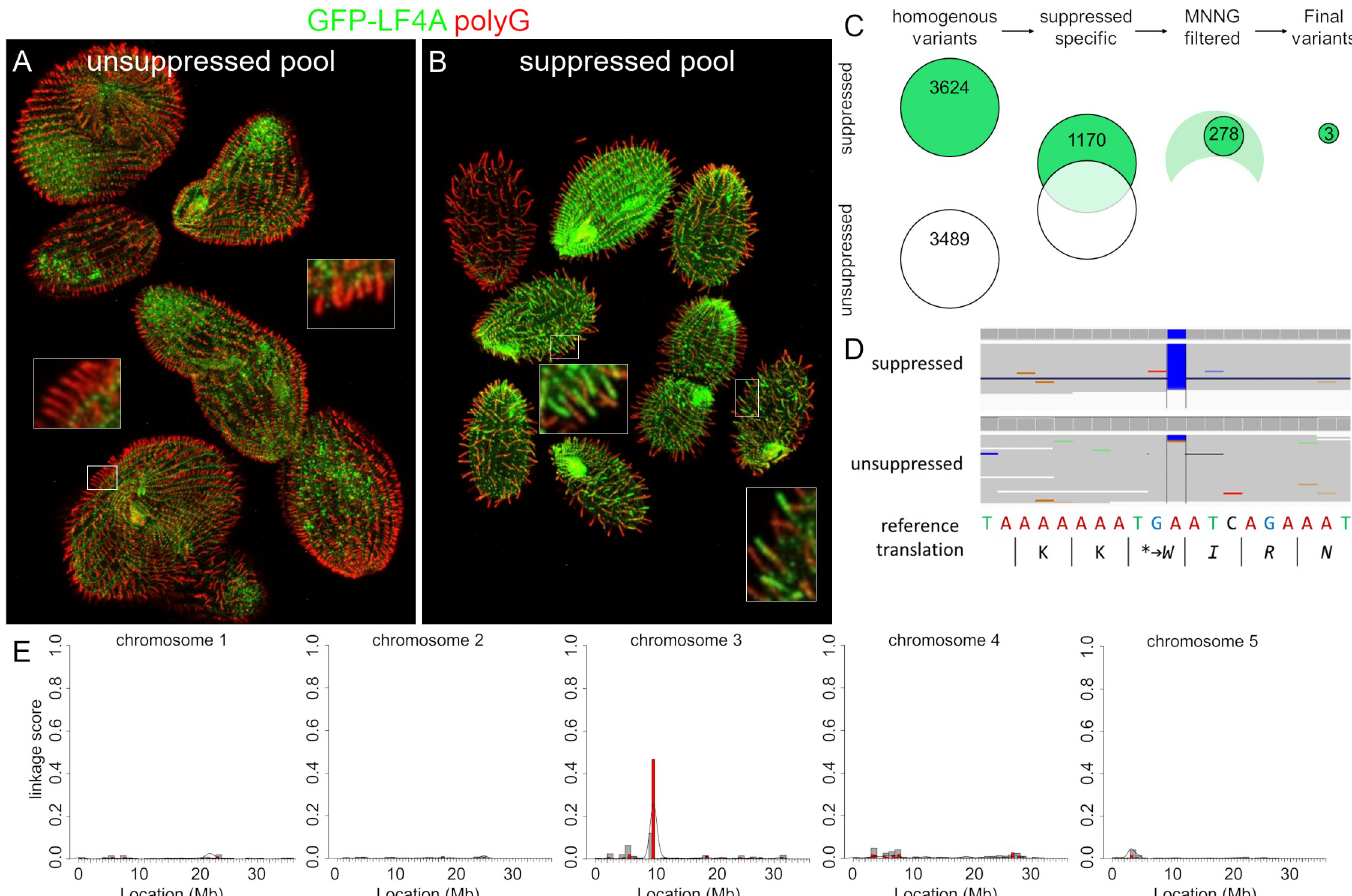
Fig 5. The extragenic suppressor clone SUP1 has a mutation in CDKR1 . (A-B) Immunofluorescence images of (unsuppressed and suppressed) pools of F2 progeny derived from a single sup1/SUP1 + (after an overnight exposure to Cd 2+ ) that were subsequently subjected to whole genome sequencing. Note the patterns of GFP-LF4A inside cilia: the base accumulation in the non-suppressed pool and the ciliary shaft and tip signals in the suppressed pool (see insets for higher magnifications). (C) The results of variant subtraction and filtering based on the alignment of sequencing reads to the macronuclear reference genome. Among the 278 variants consistent with nitrosoguanidine (MNNG) mutagenesis, three candidate variants affect a gene product and have a high fraction of reads supporting the alternative base in the mutant pool (see S1 Table). (D) An IGV browser view of the macronuclear genome sequence of TTHERM_01080590 ( CDKR1 ) that contains the variant scf_8254401:105680 T to C. This point mutation, supported by 100% of the sequencing reads from the mutant pool, changes the stop codon and adds a short peptide to the C-terminus of the predicted product. (E) An allelic composition contrast analysis of the variant co-segregation across all micronuclear chromosomes. The normalized linkage scores show the difference in the allelic composition between the mutant and the wild-type pool at each variant site. This reveals a cluster of variant co-segregation at 9–10 Mb on the micronuclear chromosome 3.